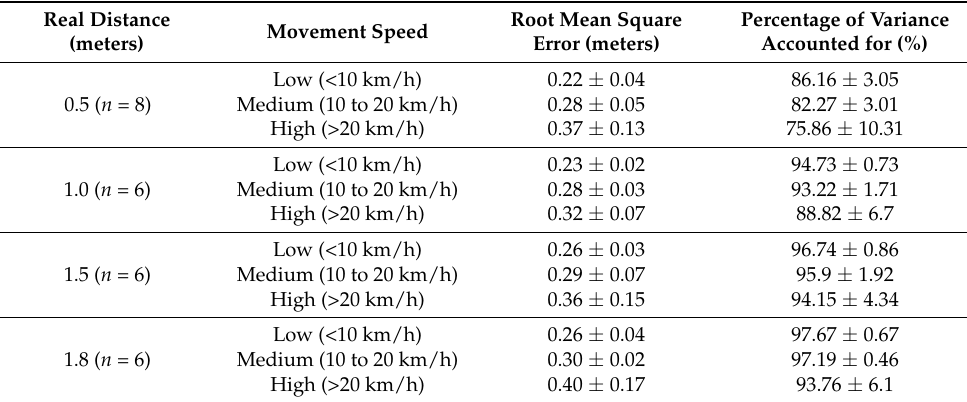
Table 1. Root mean square error and percentage of variance accounted for considered inter-tags distances according to the different movement